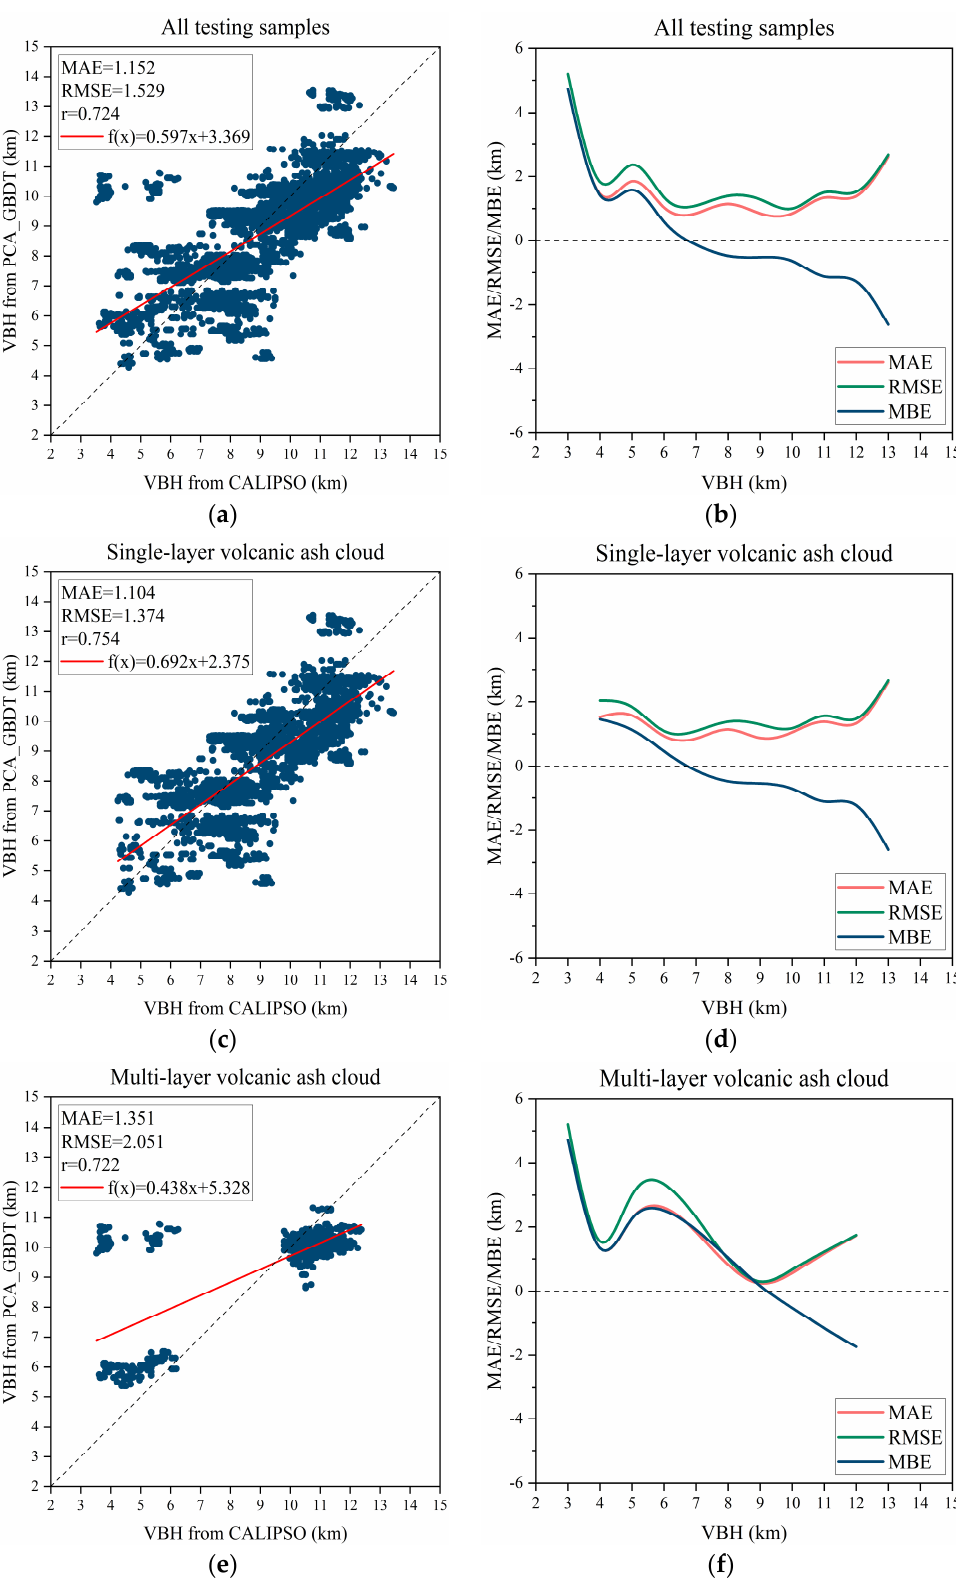
Figure 11. Validation of retrieved VBH for all sample datasets ( a , b ), single-layer volcanic ash cloud sample sets ( c , d ), and multi-layer volcanic ash cloud sample sets ( e , f ).